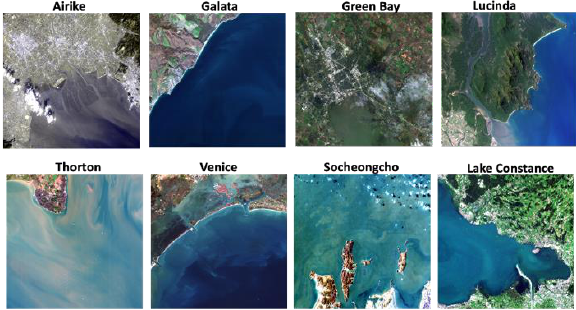
Figure 2 . True colour composites of DESIS Level 1B for the eight investigated regions.